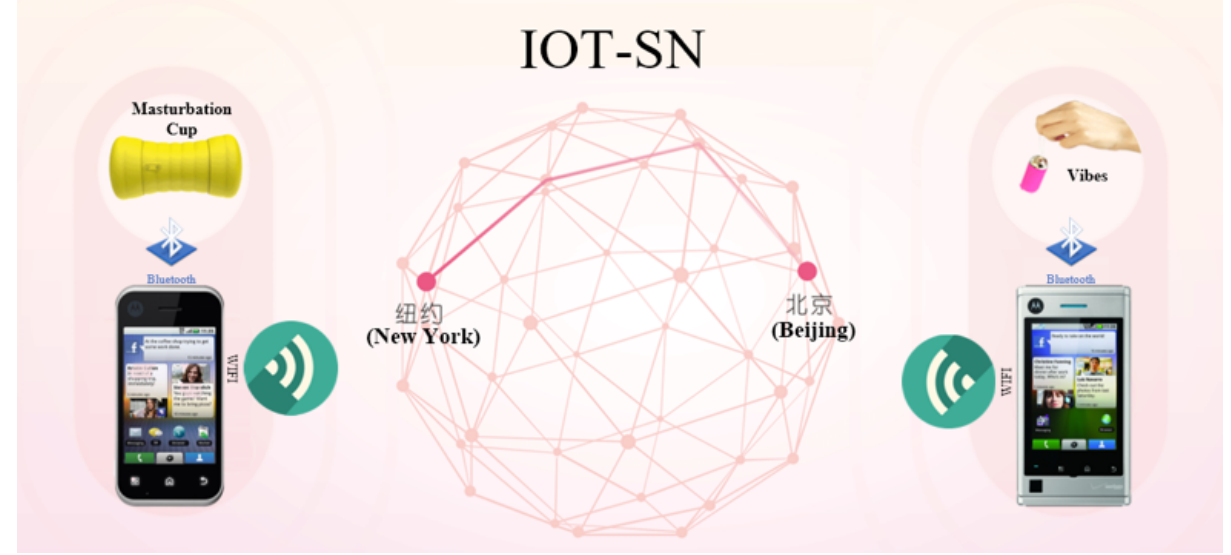
Figure 1. Typical usage scenario of sexual behavior acquisition system